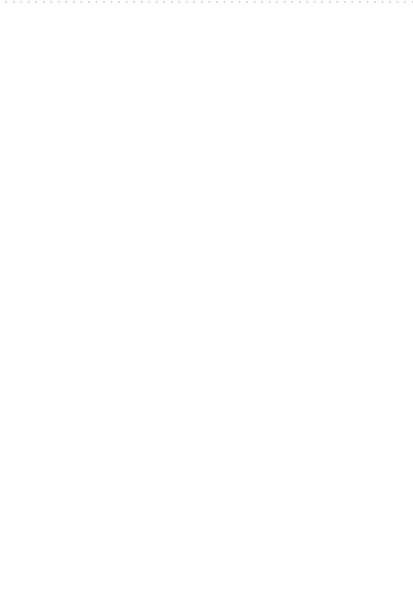
Table 3. Inter-observer agreement of texture parameters in multiphase contrast-enhanced CT imaging. Data are interclass correlation coefficients.